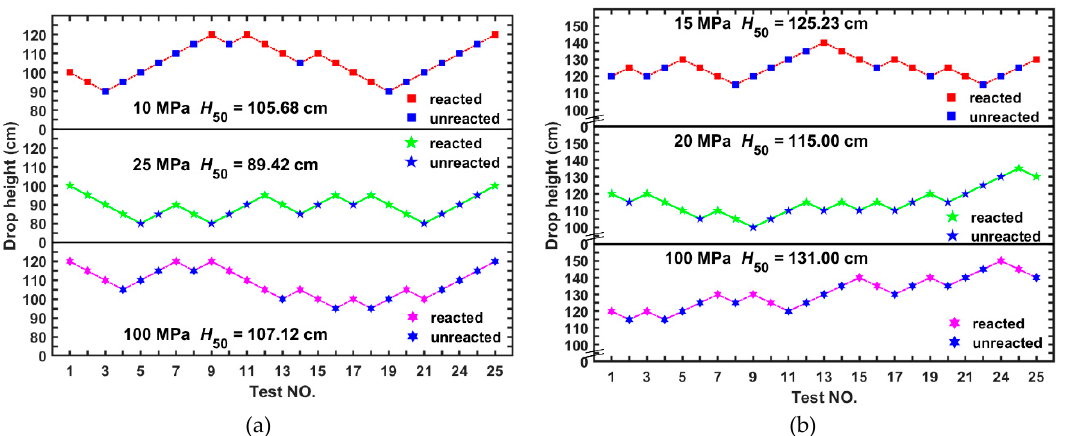
Figure 12. Drop weight test results of the HTSed reactive materials molded under different pressures: ( a ) type C; ( b ) type E.